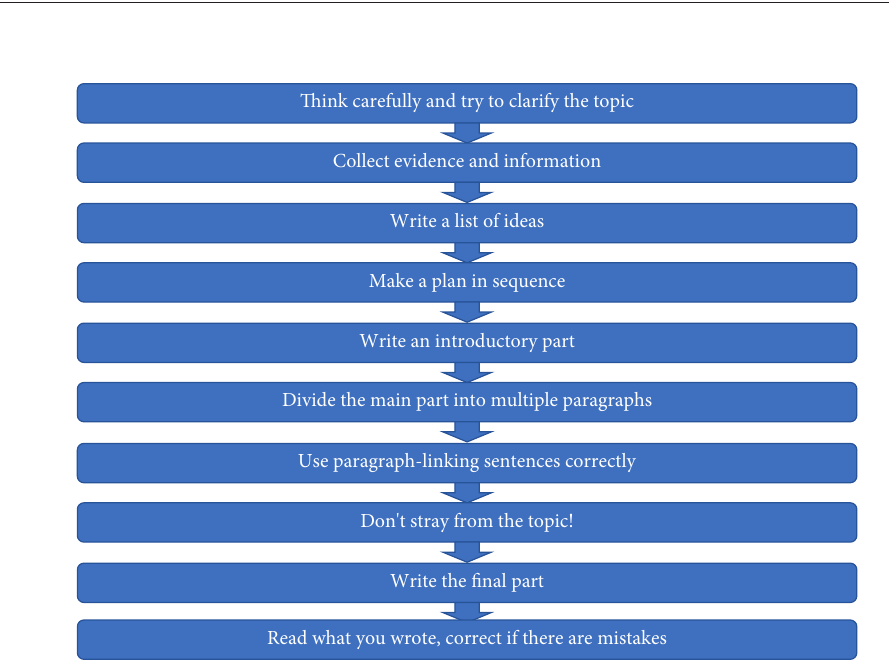
Figure 6: Stages of work on writing an